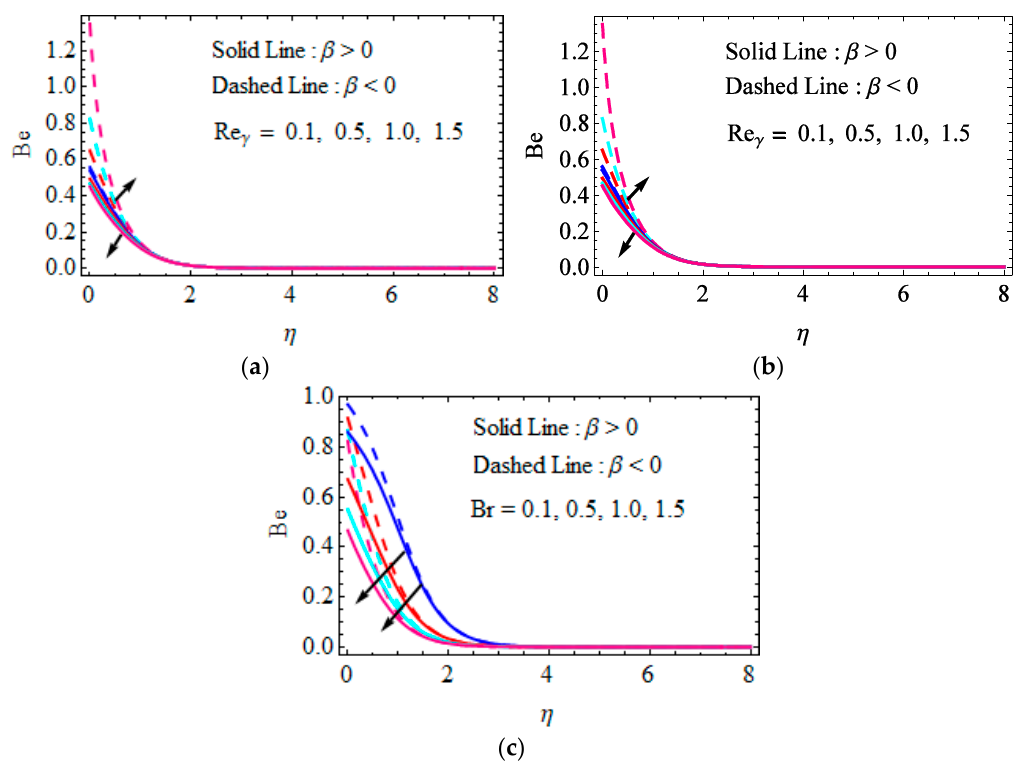
Figure 8. ( a – c ) The impact of the numerous variables of Be : ( a ) δ , ( b ) Re γ and ( c ) Br .